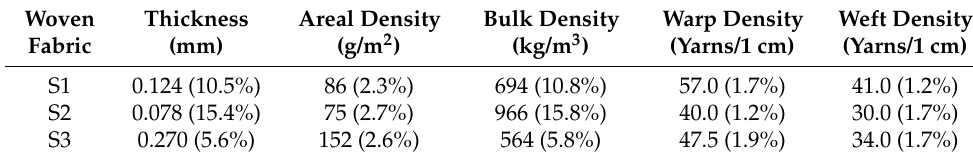
Table 2. Parameters of woven